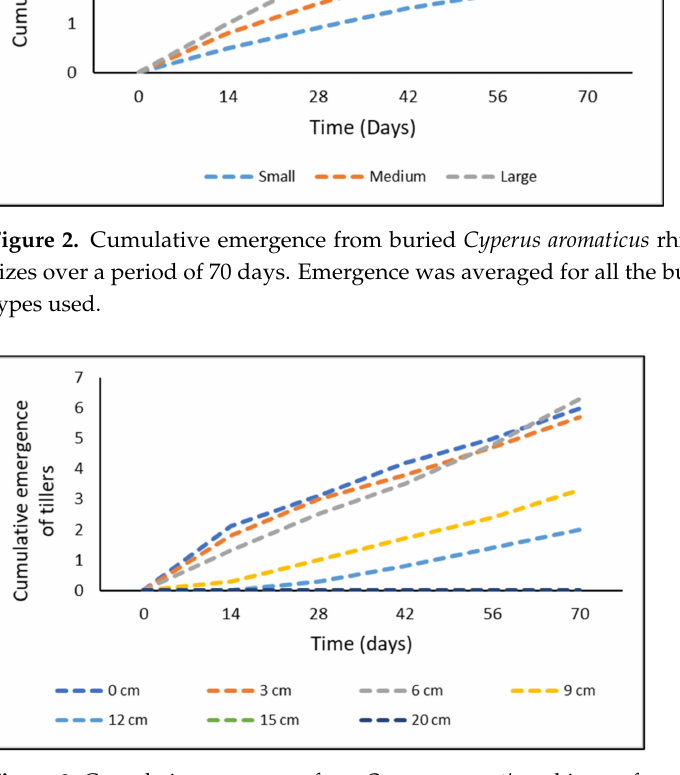
Figure 3. Cumulative emergence from Cyperus aromaticus rhizome fragments buried at various depths over a period of 70 days. Emergence was averaged for all the rhizome sizes and both soil types